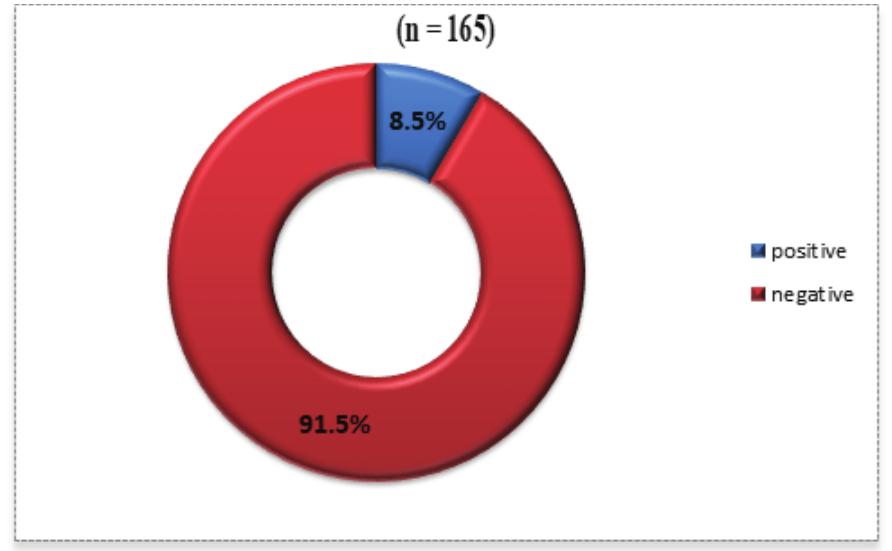
Figure 2: The test result of HBsAg among pregnant women attending Antenatal Care (ANC) Clinic at the Um Dafog area, South Darfur State, Sudan during July 2018 to January